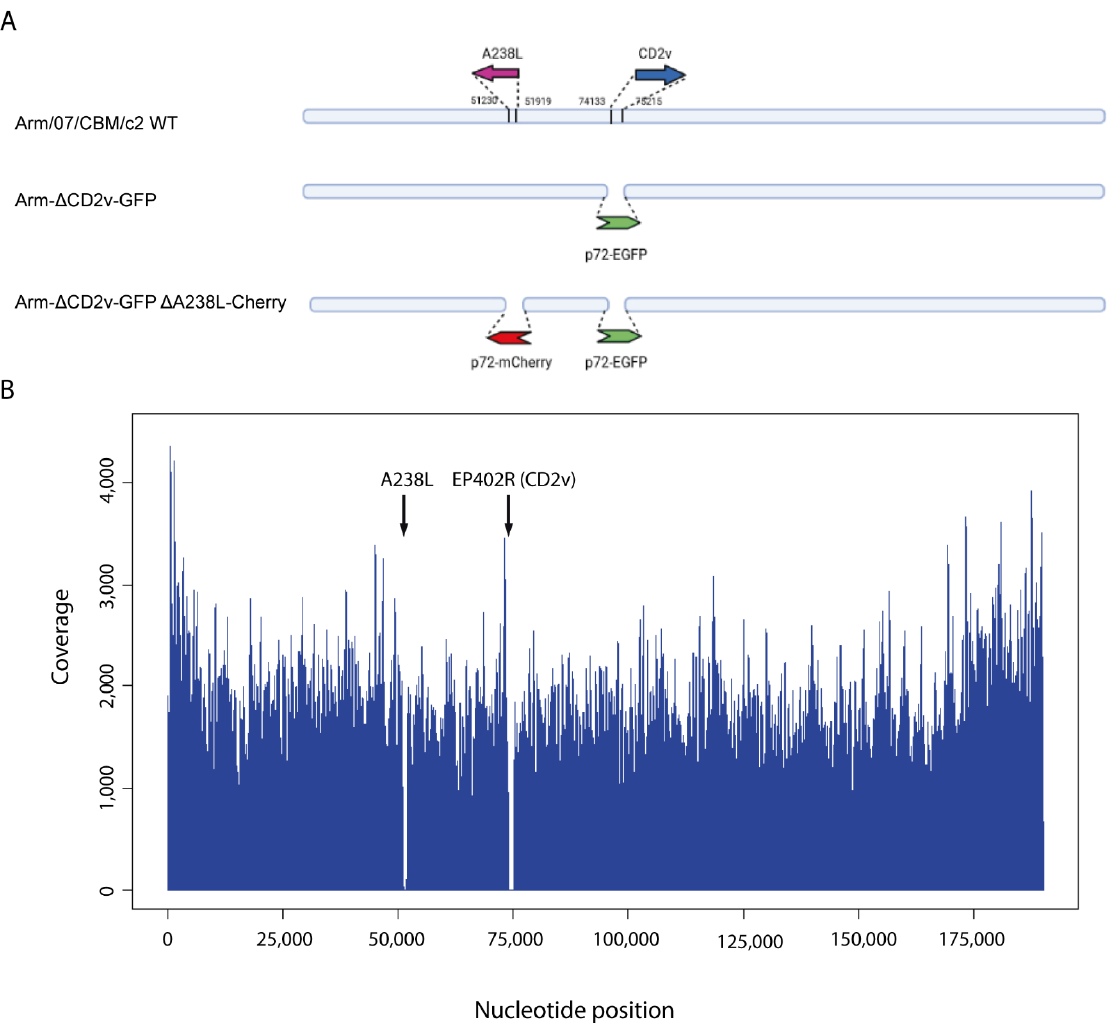
Figure 1. Generation of the recombinant Arm- Δ CD2v- Δ A238L. ( A ) Schematic for the generation of Arm- Δ CD2v- Δ A238L. Representation of the original Arm/07/CBM/c2 genome, the intermediate re- combinant virus Arm- Δ CD2v-GFP generated by substitution of EP402R gene (coding for CD2v) with the EGFP gene under the control of the p72 promoter; and the final Arm- Δ CD2v- Δ A238L gen- erated from the Arm- Δ CD2v-GFP recombinant virus by substitution of A238L gene with the mCherry gene under the control of the p72 promoter. ( B ) Whole genome coverage plot using Illu- mina reads of the recombinant Arm- Δ CD2v- Δ A238L virus mapped to the ASFV Arm/07/CBM/c2 genome.